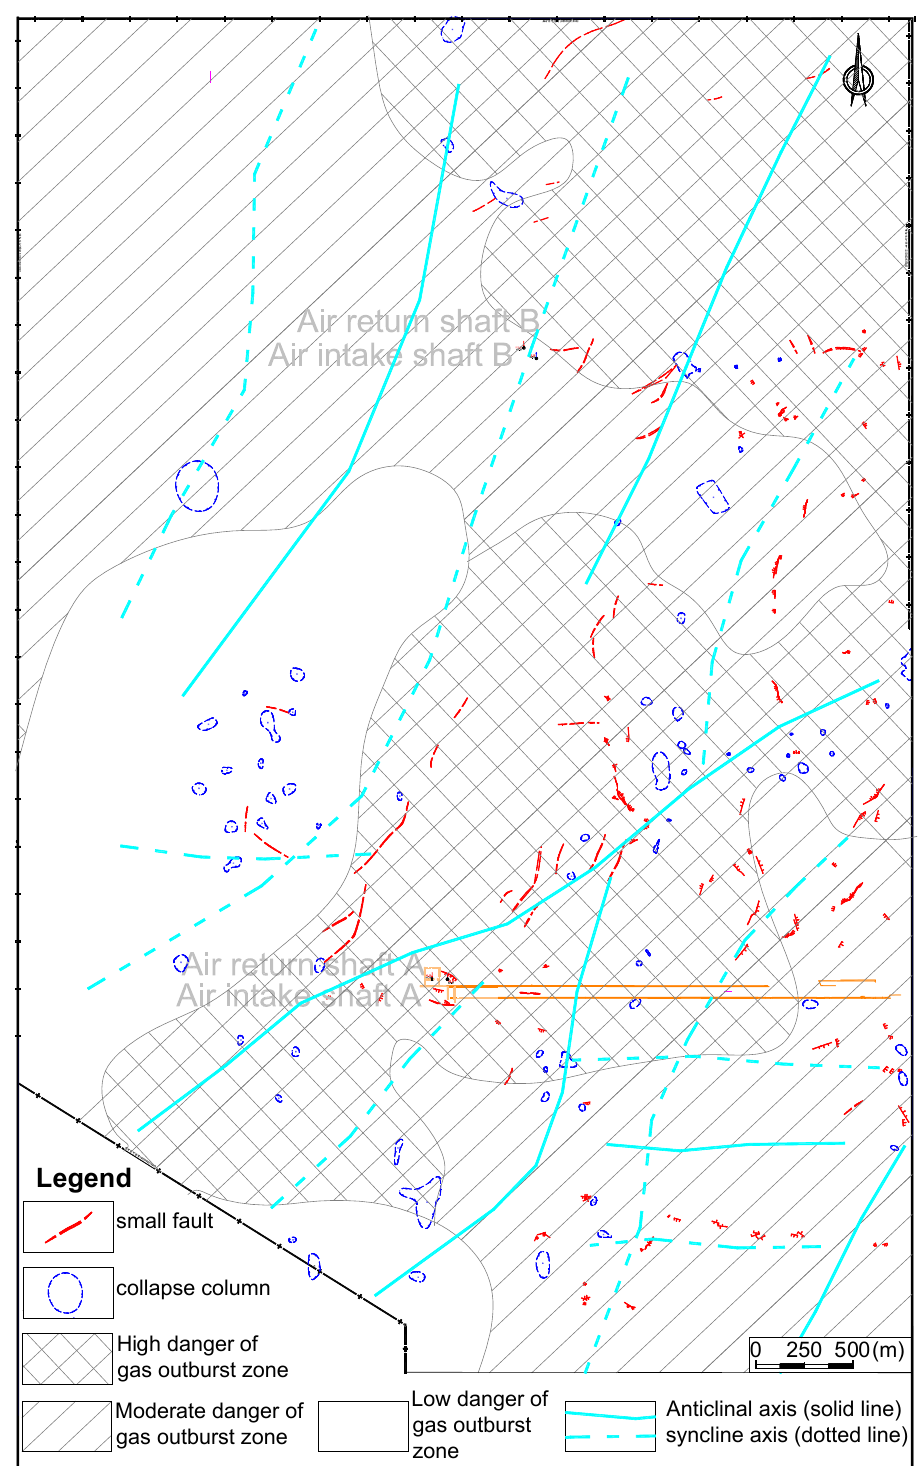
Figure 7. The zoning map of gas outburst risks of the No. 3 coal seam.